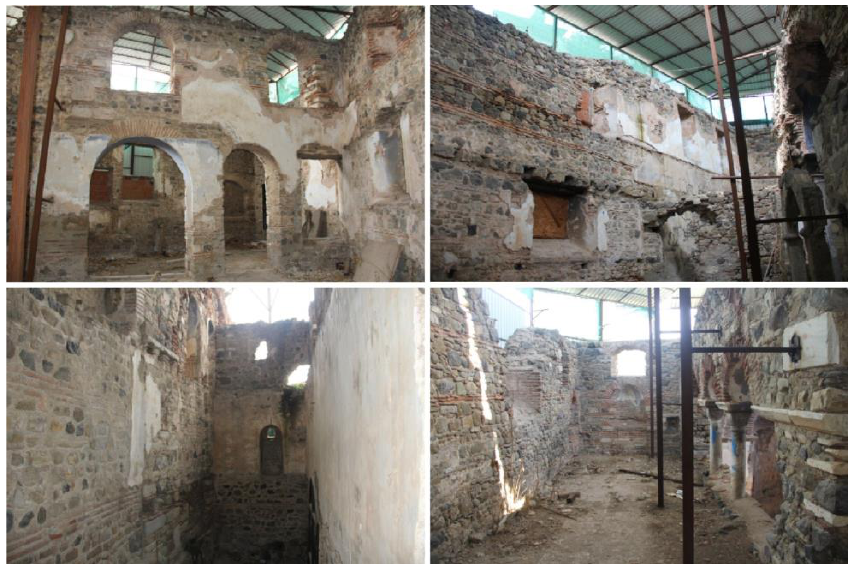
Figure 9. Views of West-South Narthex, St. Nikolaos Chapel and Haralambos Chapel.